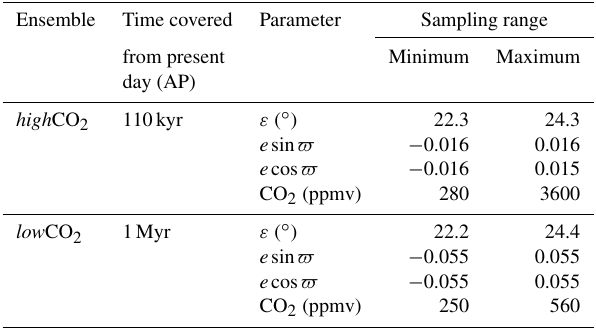
Table 1. Ensemble set-ups: sampling ranges for input parameters (obliquity, e sin (cid:36) , e cos (cid:36) and CO 2 ) for the high CO 2 and low CO 2 ensembles. Ensemble Time covered